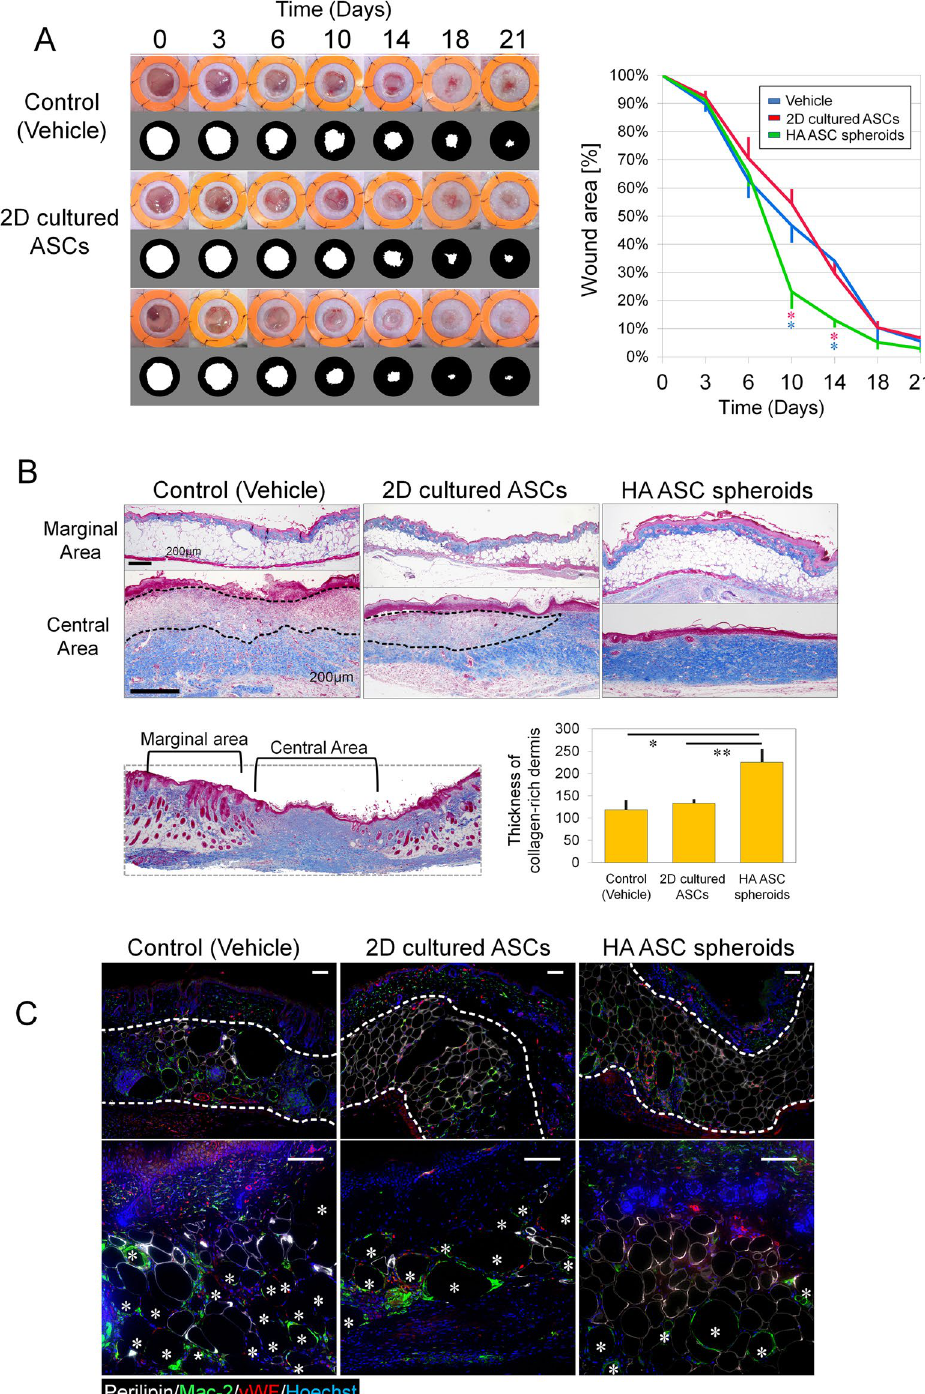
Figure 4. Wound healing of skin defects in diabetic mice. ( A ) Representative photos of wound healing in full- thickness cutaneous ulcers (left) and quantification of wound-opening sizes at different time points (right) in db/db mice. The inner diameter of the splints was 14 mm; n = 4 ulcers; * p day10 = 0.0245; * p day14 = 0.021. ( B ) Mallory-Azan trichrome stain of wound-tissue samples harvested 24 days post surgery (upper). Collagen was stained blue. Wound pathohistology was evaluated via quantification of dermal collagen deposition (lower). The dashed line indicates the collagen-poor area in the dermis; n = 4 ulcers; five points were photographically measured in each sample; * p = 0.040, ** p = 0.043. Scale bars = 200 µ m. ( C ) Immunofluorescence of the adipose layer of the wound: viable adipocytes (perilipin, white), macrophages (mac-2, green), vasculature (vWF, red), and nuclei (blue). * Represents crown-like structures which are perilipin-negative round area (oil drops) surrounded by Mac-2-positive infiltrated macrophages. Scale bars = 100 µ